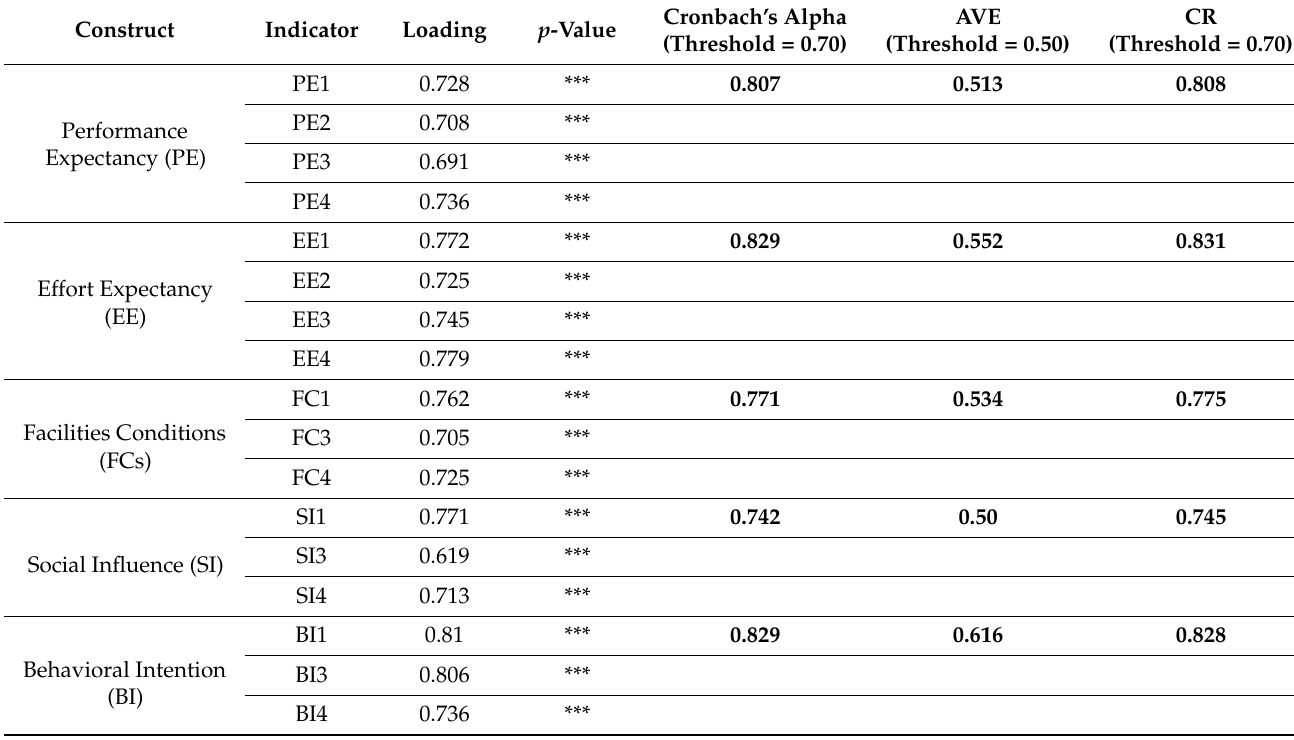
Table 6. Convergent validity.